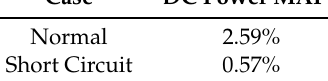
Table 10. Validation Results.